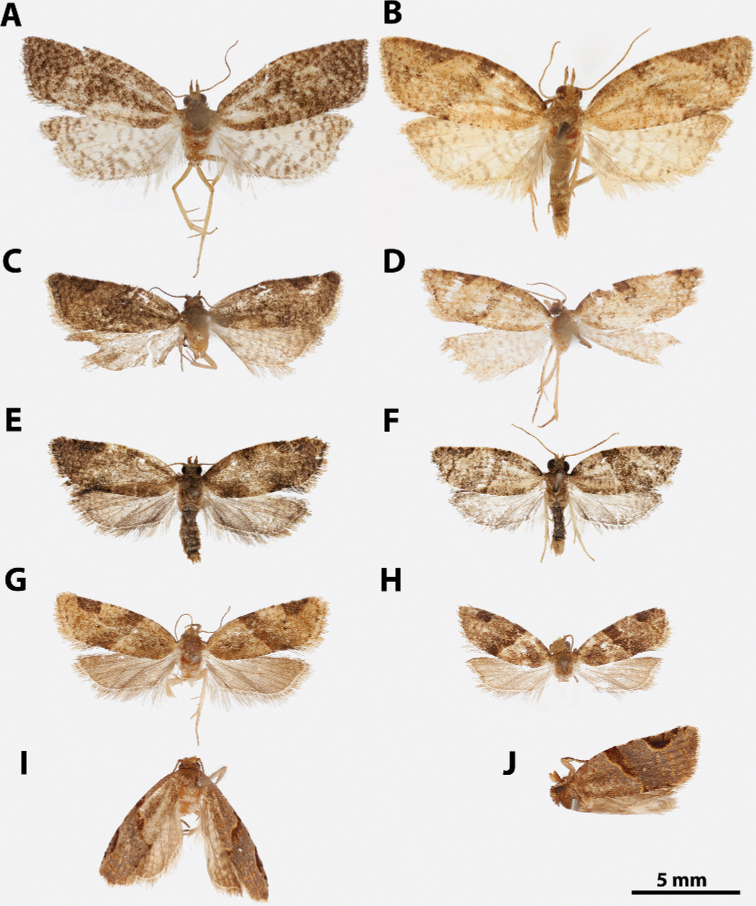
Clepsis adults. ACle.
deroni sp. nov. holotype ♀, Dominican Republic (CMNH) BCle.
deroni sp. nov. paratype ♂, Dominican Republic (CUIC) CCle.
jamesstewarti sp. nov. holotype ♀, Dominican Republic (CMNH) DCle.
jamesstewarti sp. nov. paratype ♂, Dominican Republic (CMNH) ECle.
davisi sp. nov. holotype ♀, Guadeloupe (CUIC) FCle.
davisi sp. nov. paratype ♂, Guadeloupe (CUIC) GCle.
peritana ♀, Cuba (USNM) HCle.
peritana ♂, Cuba (CUIC) ICle.
peroniae sp. nov. holotype ♀, Dominican Republic, dorsal (USNM) J same as previous, lateral, rotated for ease of comparison.